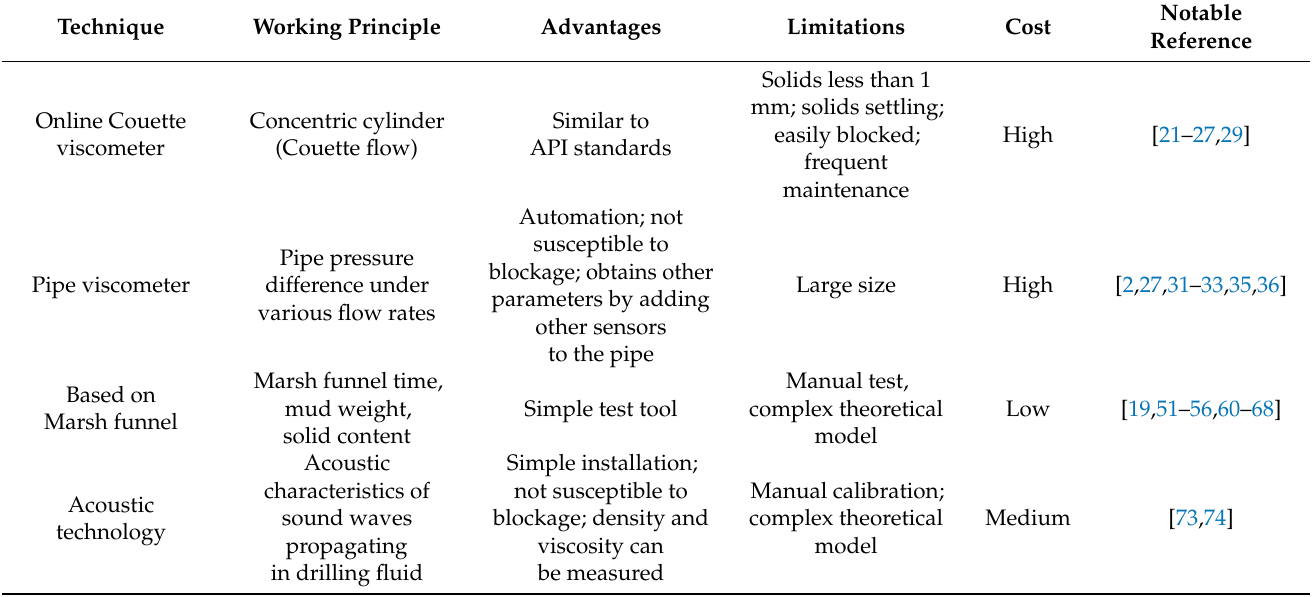
Table 3. Comparison of measurement